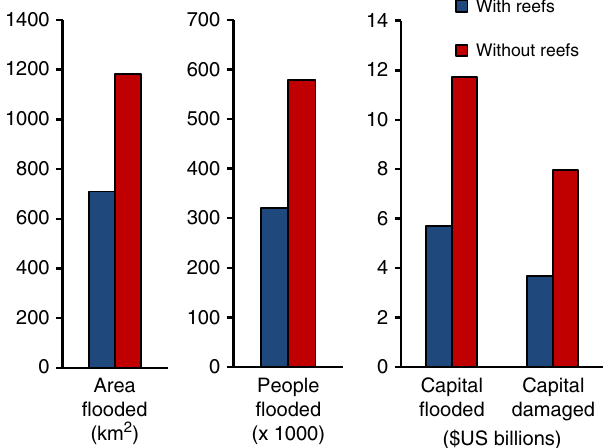
Fig. 2 Annual expected bene fi ts from coral reefs for fl ood protection. Estimates of the effects of reefs on avoided fl ooding to land, people, exposed capital and damaged capital. The differences between scenarios with and without reefs are avoided damages or present bene fi ts of reefs